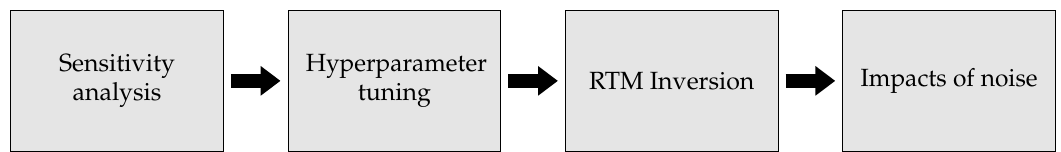
Figure 1. The first step consists of identifying which biophysical variables can be detected by S2 while the second step uses Bayesian optimization to find the best parameters for the various models. Lastly, the third and fourth steps test the performance of the various algorithms for inverting simulated S2-like data using Radiative Transfer Models in pure and noisy